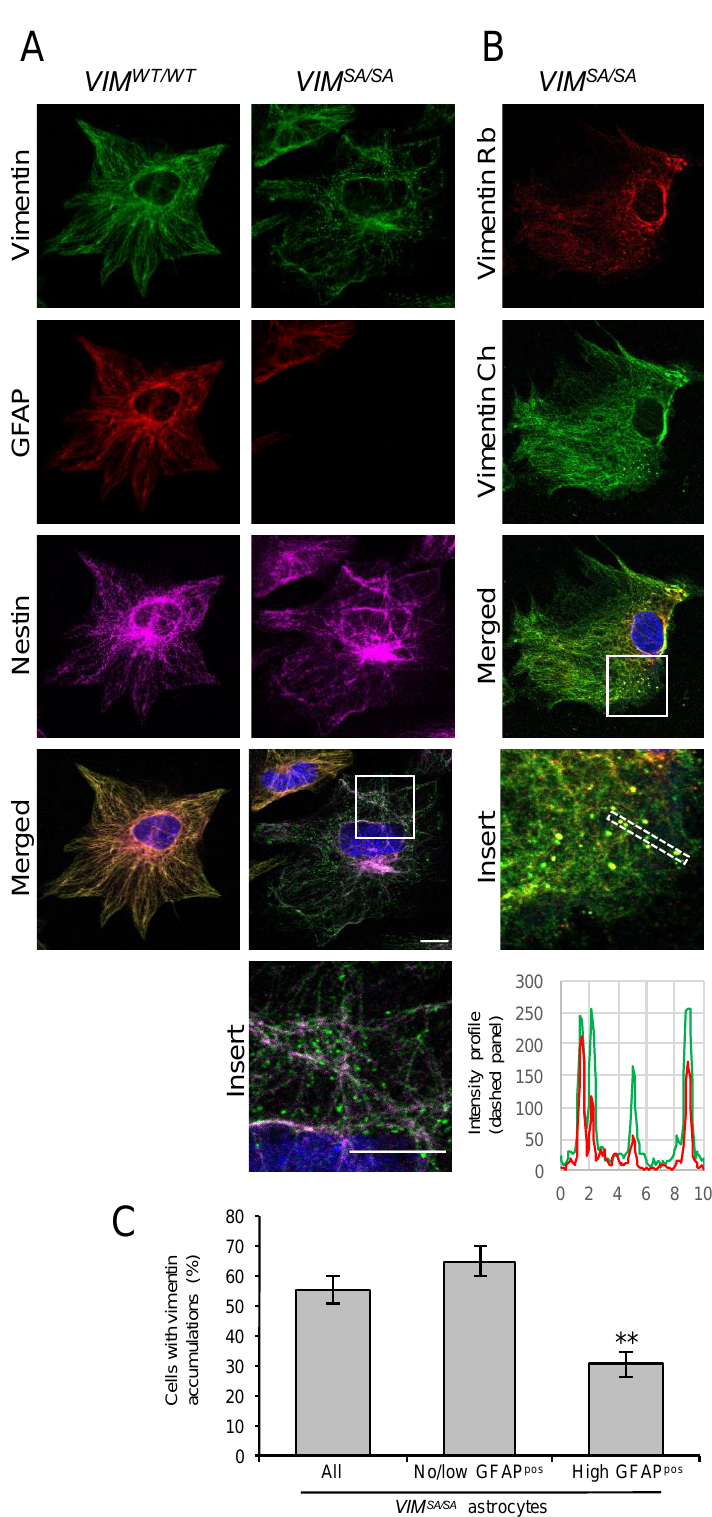
Figure 1. Immature VIM SA/SA astrocytes contain vimentin accumulations. ( A ) Immature VIM WT/WT and VIM SA/SA astrocytes were labeled with antibodies against vimentin (green), glial fibrillary acidic protein (GFAP) (red), and nestin (purple). Nuclei were visualized with DAPI (blue). Vimentin